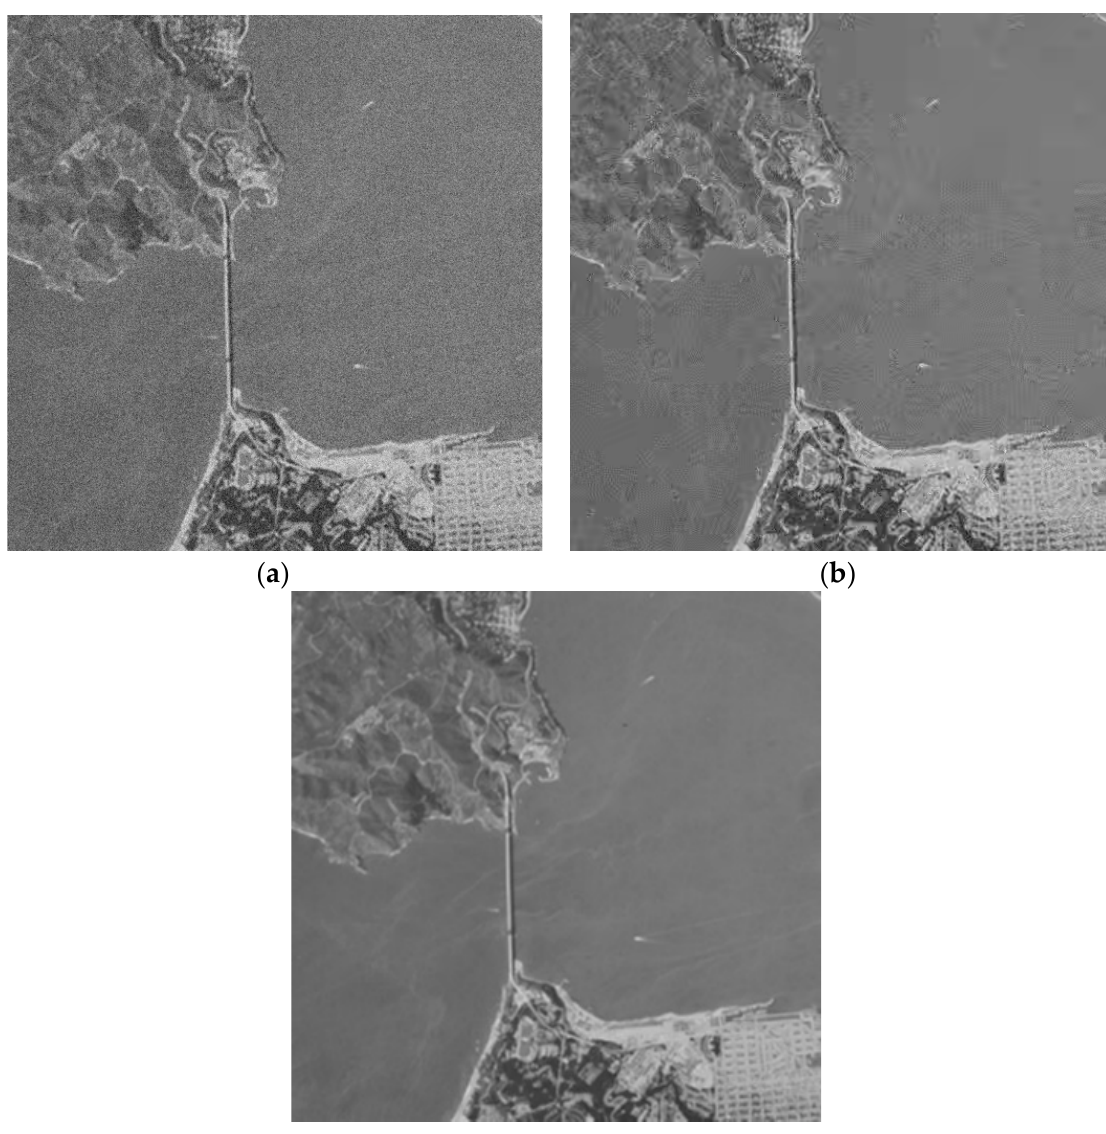
Figure 15. Noisy image Frisco ( a ) and the same image compressed in OOP ( b ), noise variance equal to 196, and the noise-free image ( c ).